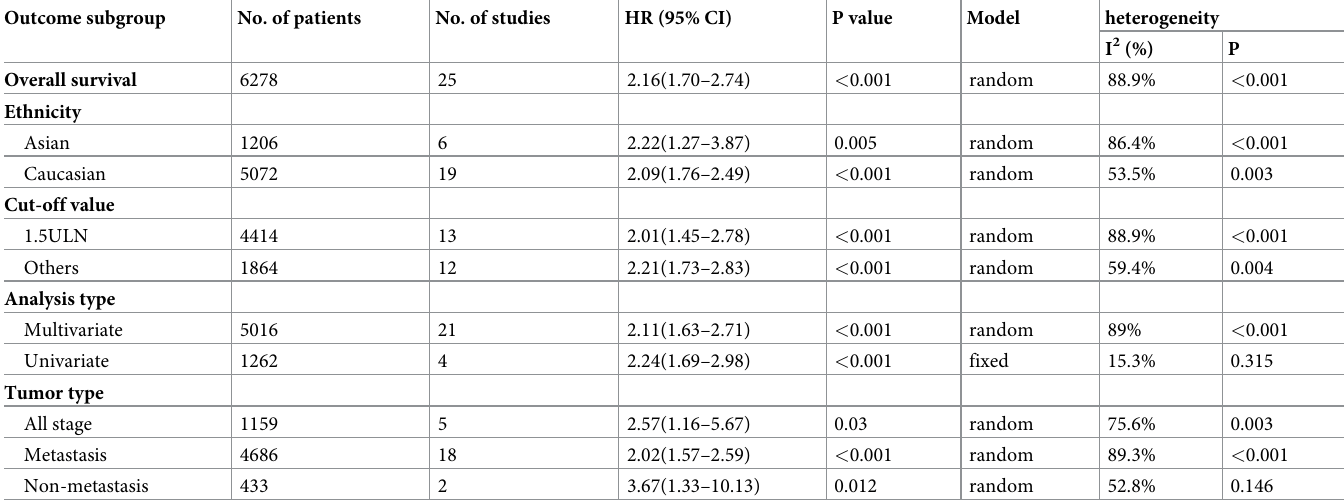
Table 2. Pooled hazard ratios for OS according to subgroup